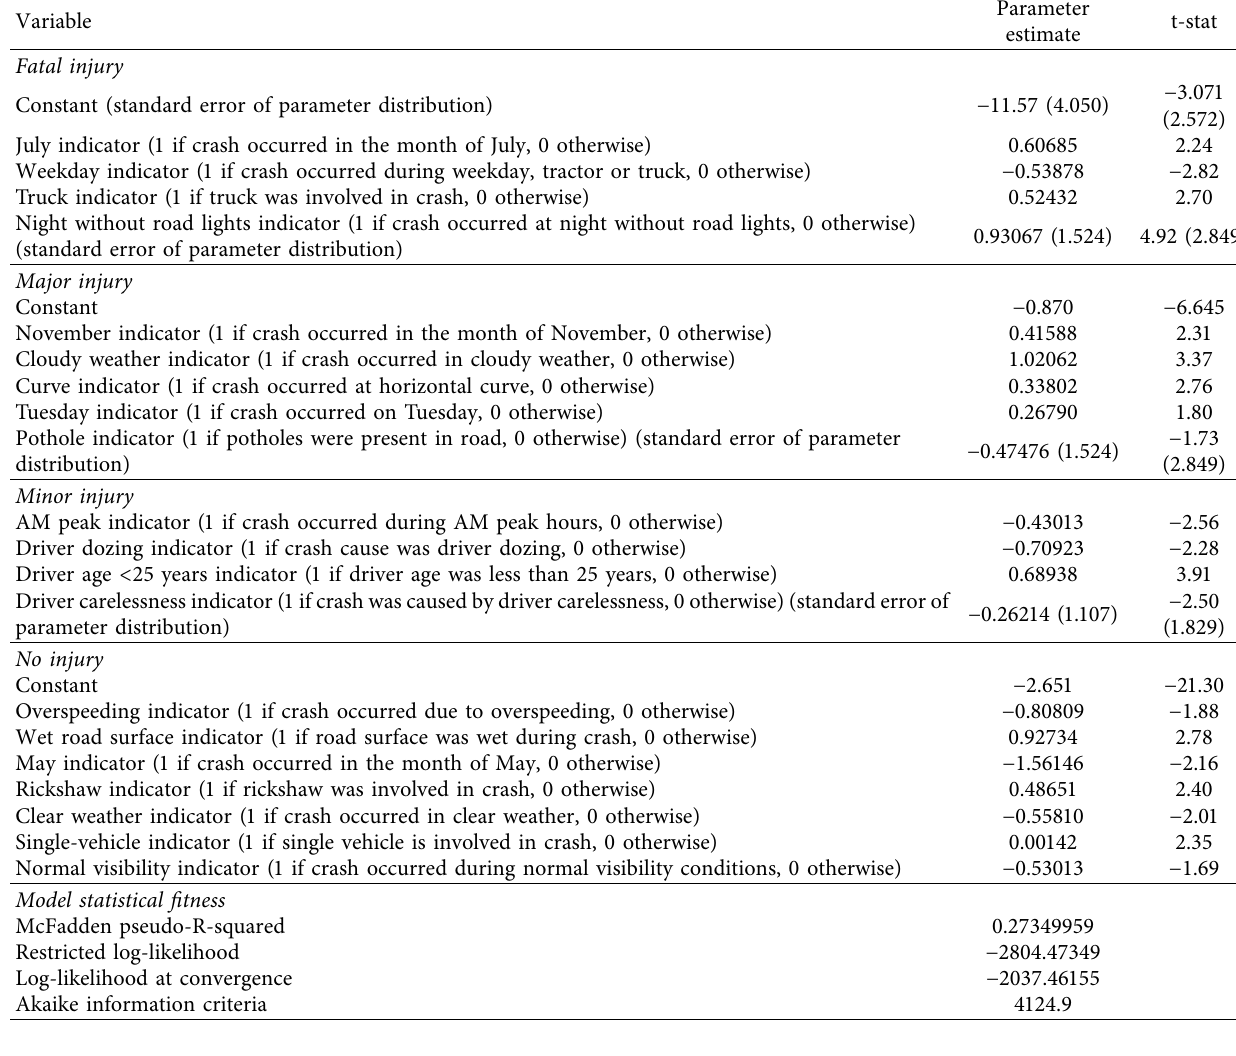
Table 2: Estimated model results for crash severity